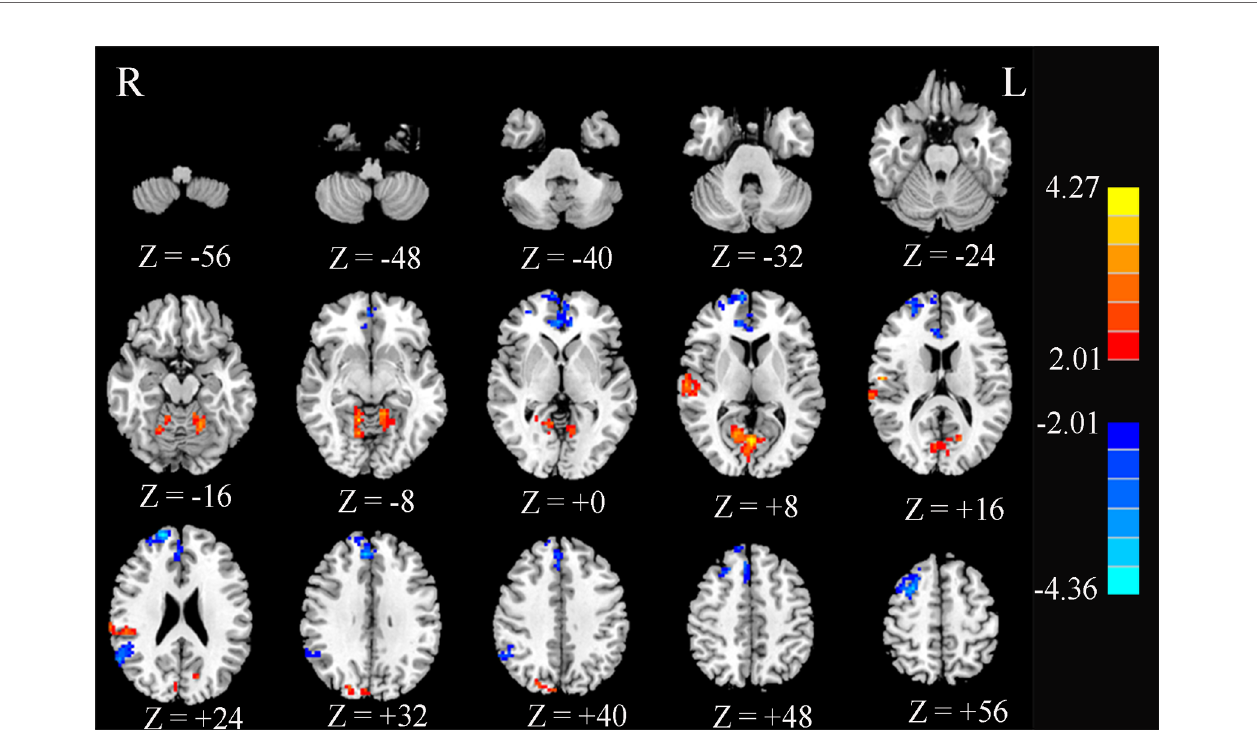
FIGURE 4 | Signi fi cant differences in the functional connectivity of the posterior cingulate cortex (PCC) between type 2 diabetes patients without cognitive and microvascular complications and healthy controls. AlphaSim-corrected threshold of p < 0.05. Z represents the Montreal Neurological Institute (MNI) coordinates on the